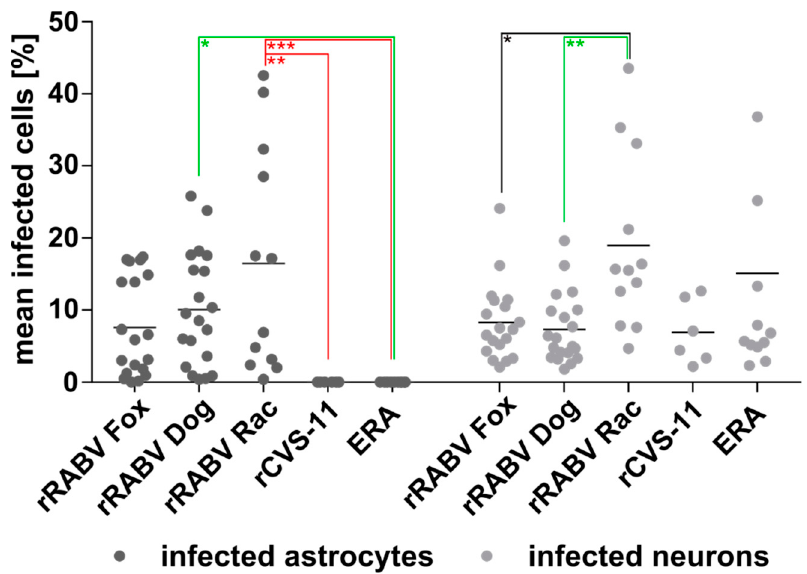
Figure 5. Percentage of field and lab RABV-infected neurons and astrocytes after i.m. inoculation. Per virus, 3 to 9 × 10 3 astrocytes and 1.5 to 4 × 10 4 neurons were counted in 19 (rRABV Fox), 20 (rRABV Dog), 12 (rRABV Rac and ERA), and six (rCVS-11) independent confocal z-stacks in three (rRABV Fox and rRABV Dog), two (rRABV RAC and ERA), and one (rCVS-11) animal (see Supplementary Table S1). Each dot represents the frequency of infected astrocytes or neurons in an analyzed z-stack. Mean values are provided as horizontal lines. * p ≤ .05; ** p ≤ .01; *** p ≤ . 001 (two-way ANOVA with Tukey’s multiple comparison test).